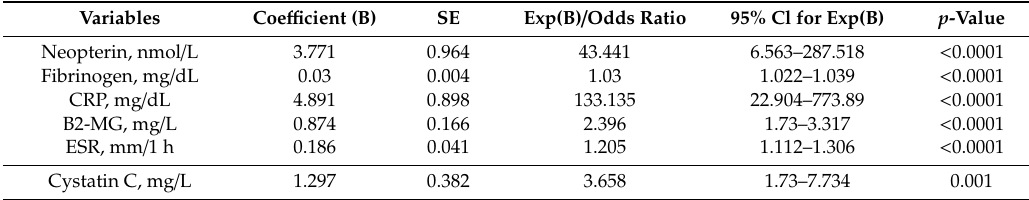
Table 5. Univariate analysis models for PAD risk.